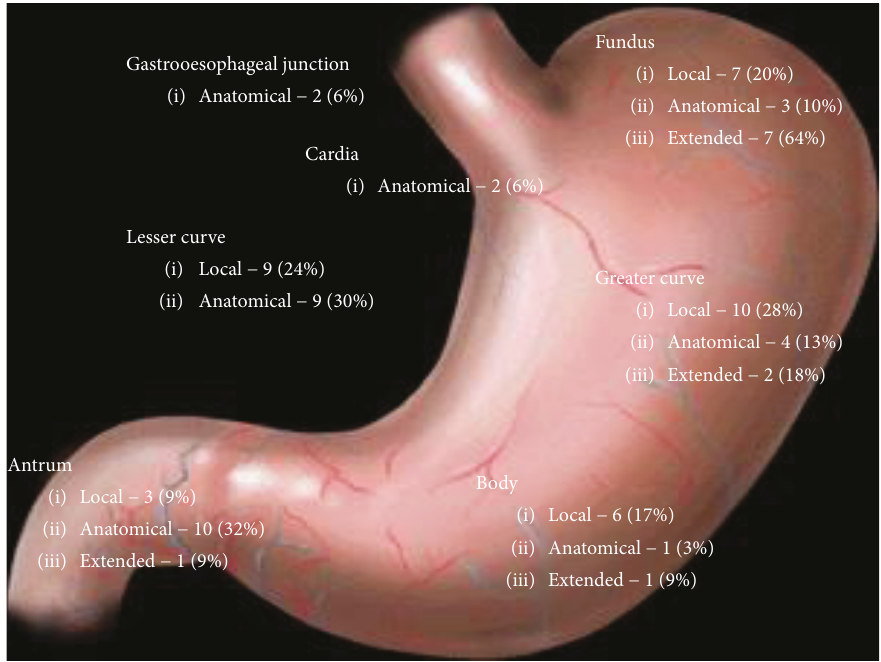
Figure 1: Distribution of gastrointestinal tumours in the anatomical, local, and extended resection